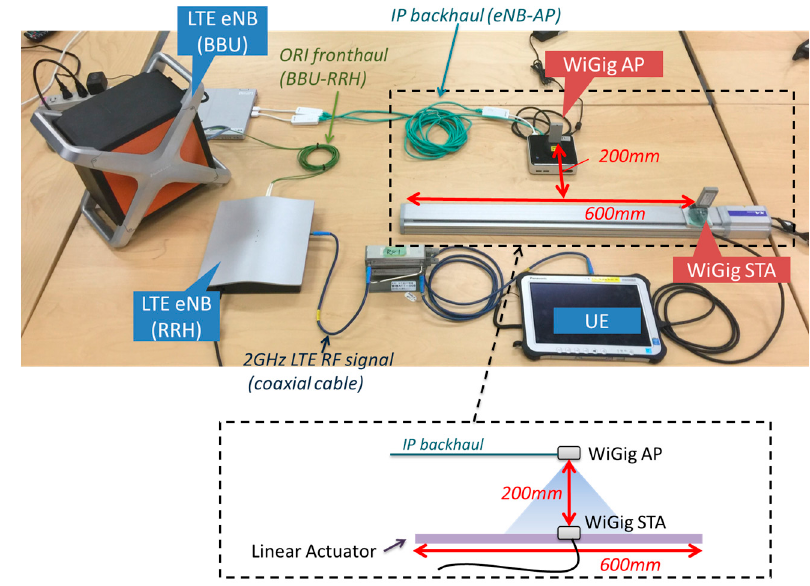
Figure 14. Experimental setup.